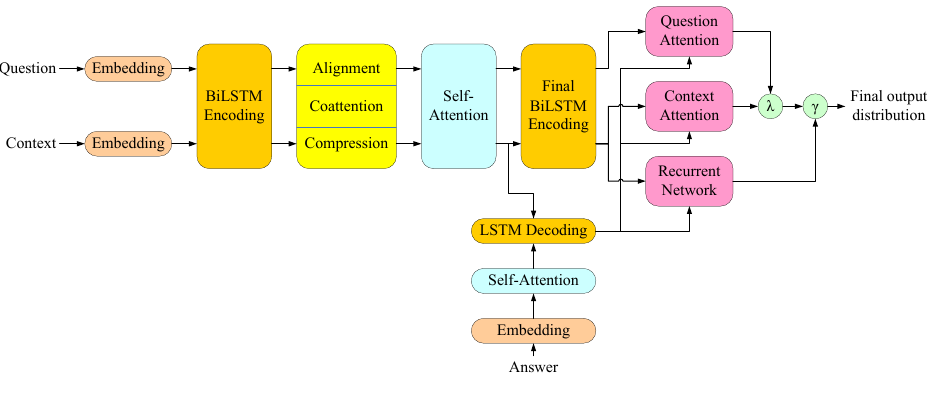
Figure 3. MQAN structure.